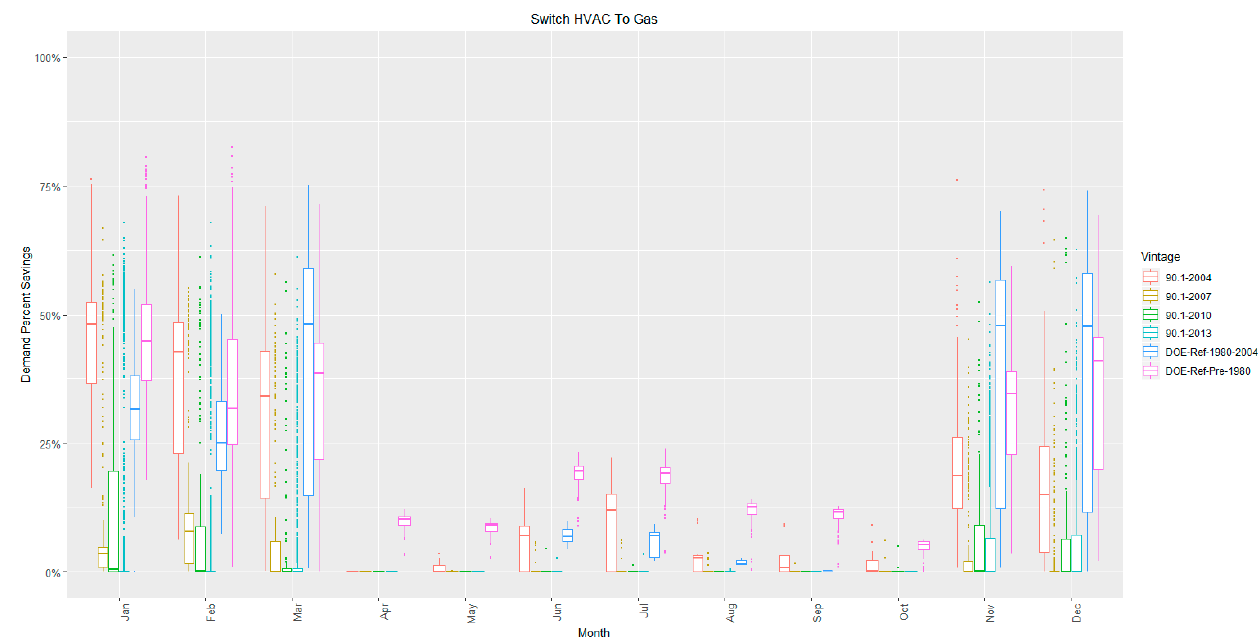
Figure 8. Distributions of potential demand reduction for a building, broken down by month and building vintage, achievable with swapping HVAC equipment from electricity to natural gas or dual-fuel equipment with a utility signal to reduce electricity use during peak